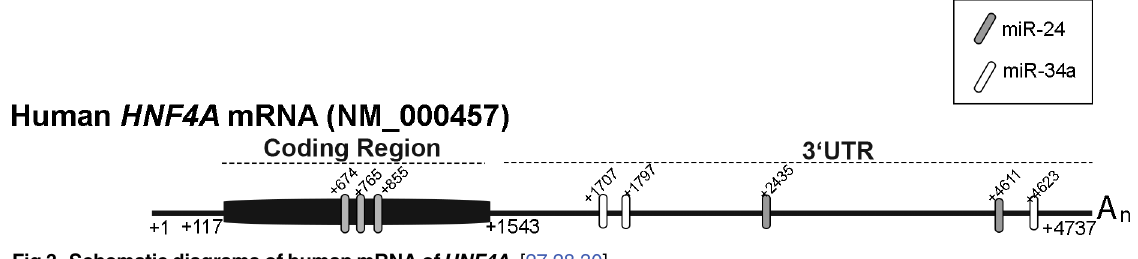
Fig 3. Schematic diagrams of human mRNA of HNF4A . [27,28,30]